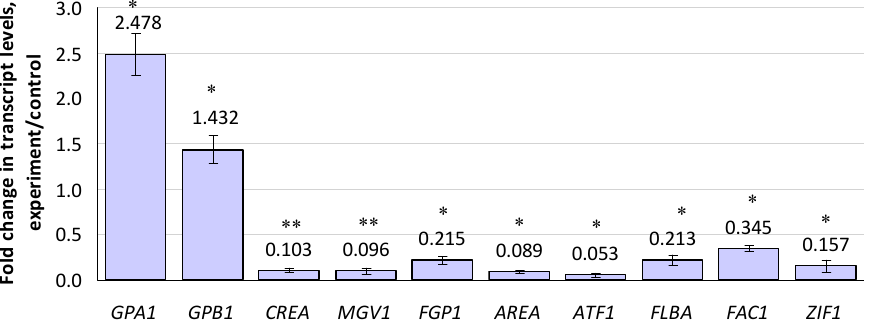
Figure 3. Effect of compactin on the relative expression of genes encoding regulatory factors. The expression level for the untreated control was considered as 1.0. EL above or below 1.0 means up- or down-regulation, respectively. Each bar is shown as M ± SD; * p < 0.05; ** p < 0.01.